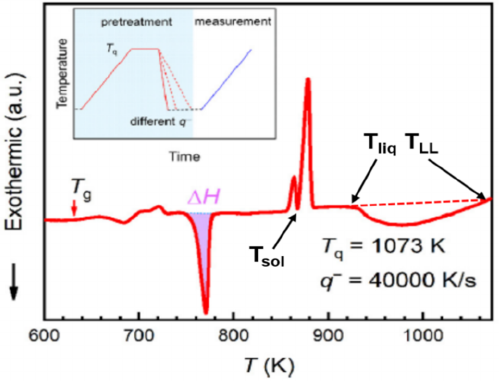
Figure 10. DSC with heating rate of 100 K/s. A typical FDSC heating curve of the sample obtained from T q = 1073 K and q − = 40,000 K/s. The enthalpy of crystallization is denoted as ΔH. The inset shows the temperature protocol of the FDSC experiments. Temperatures T sol , T liq , and T LL added. Reprinted with permission from ref. [21], Figure 3a, Copyright 2021 Elsevier. 6.1.2. Melting Transition Observed at 993 K above the Solidus Temperature T so l = 876 K of Pd 42.5 Ni 42.5 P 15